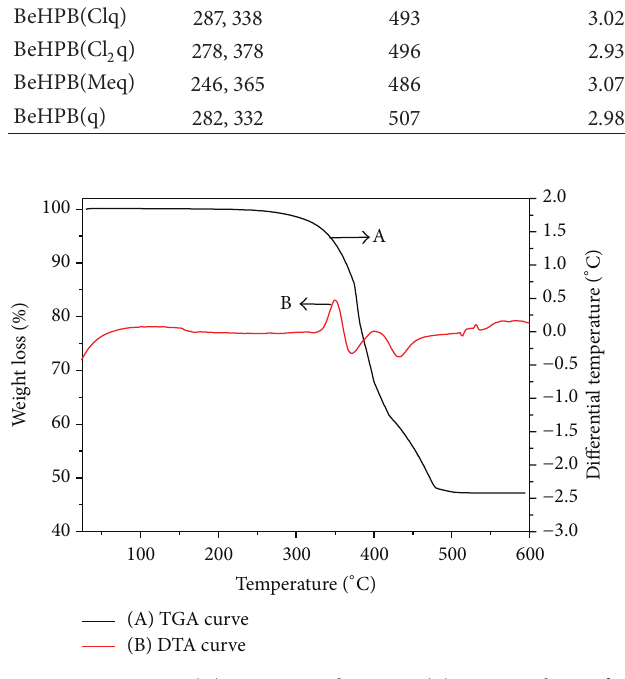
Figure 2: Curve (A): TGA, and curve (B): DTA plots of [BeHPB(Clq)] complex. Figure 3: UV-visible absorption spectra of beryllium complexes at 10 −4 M concentration in